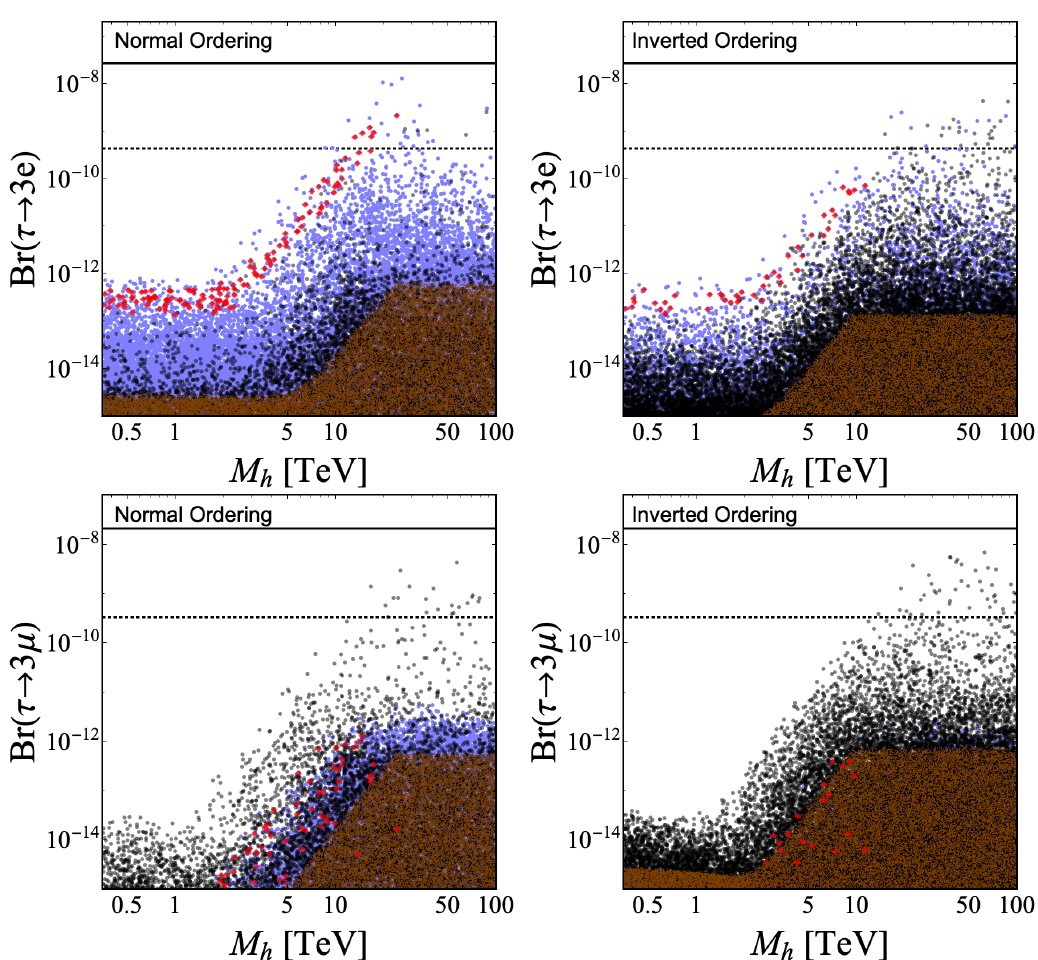
Figure 7 . Branching ratio of tri-lepton tau decays as a function of the mass M h . The colours are the same as in figure 2. Dashed lines indicate prospected experimental